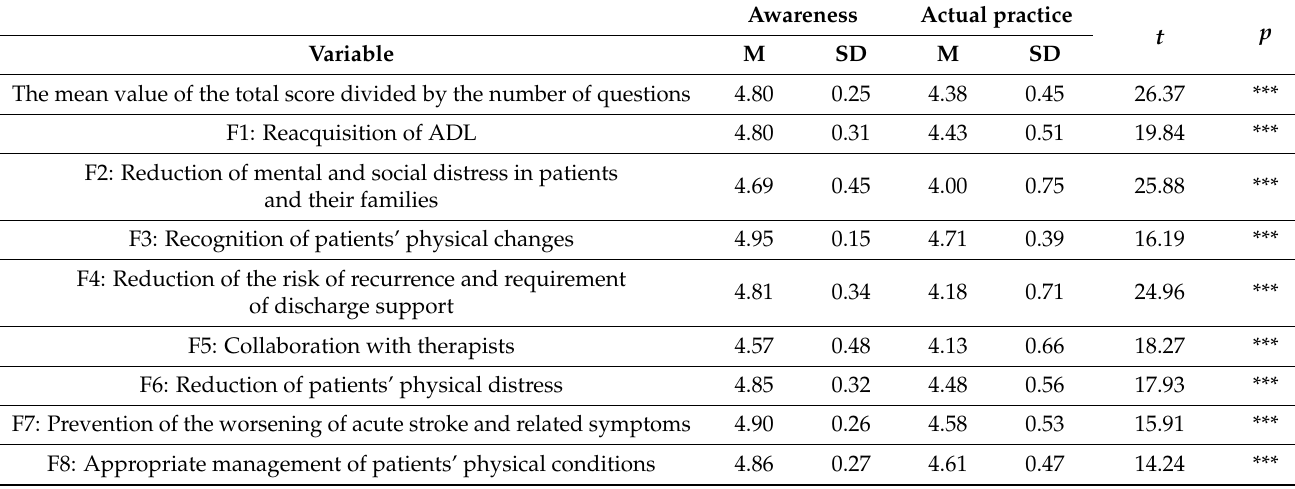
Table 3. Results of paired t -test comparing the awareness of the need for nursing for patients with acute CVA with its actual